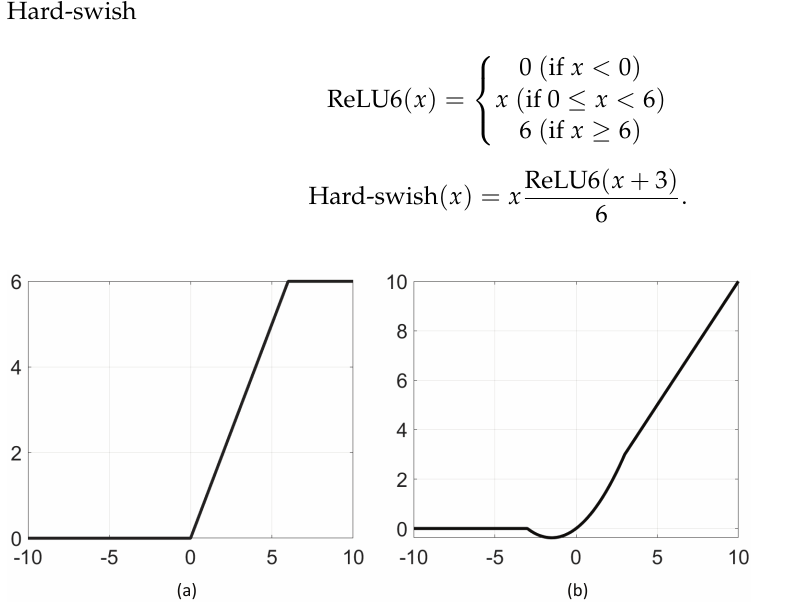
Figure 6. Graph of ReLU6 and Hard-swish: ( a ) ReLU6 ( b )